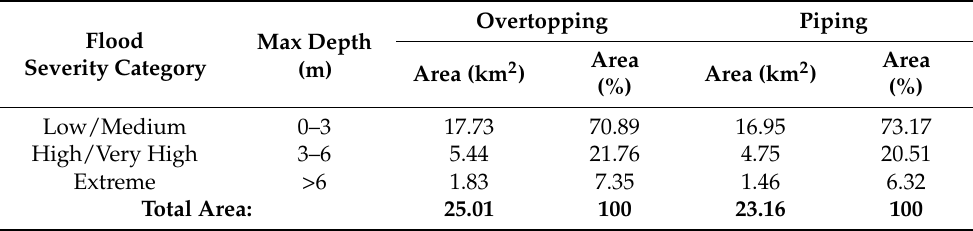
Figure 14. Maximum water depth and boundaries of inundated area in the case of piping dam failure. Table 8. Flood severity classes for maximum water depth and the inundated area per class.